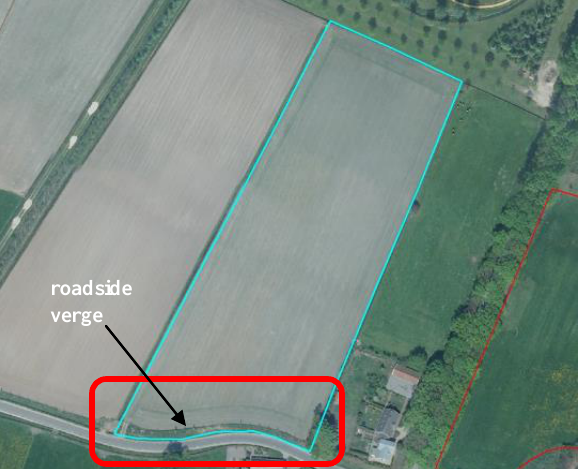
Figure 4: This example show an incorrect interpretation of the operator. Non agricultural area (a roadside verge) was included in the reference